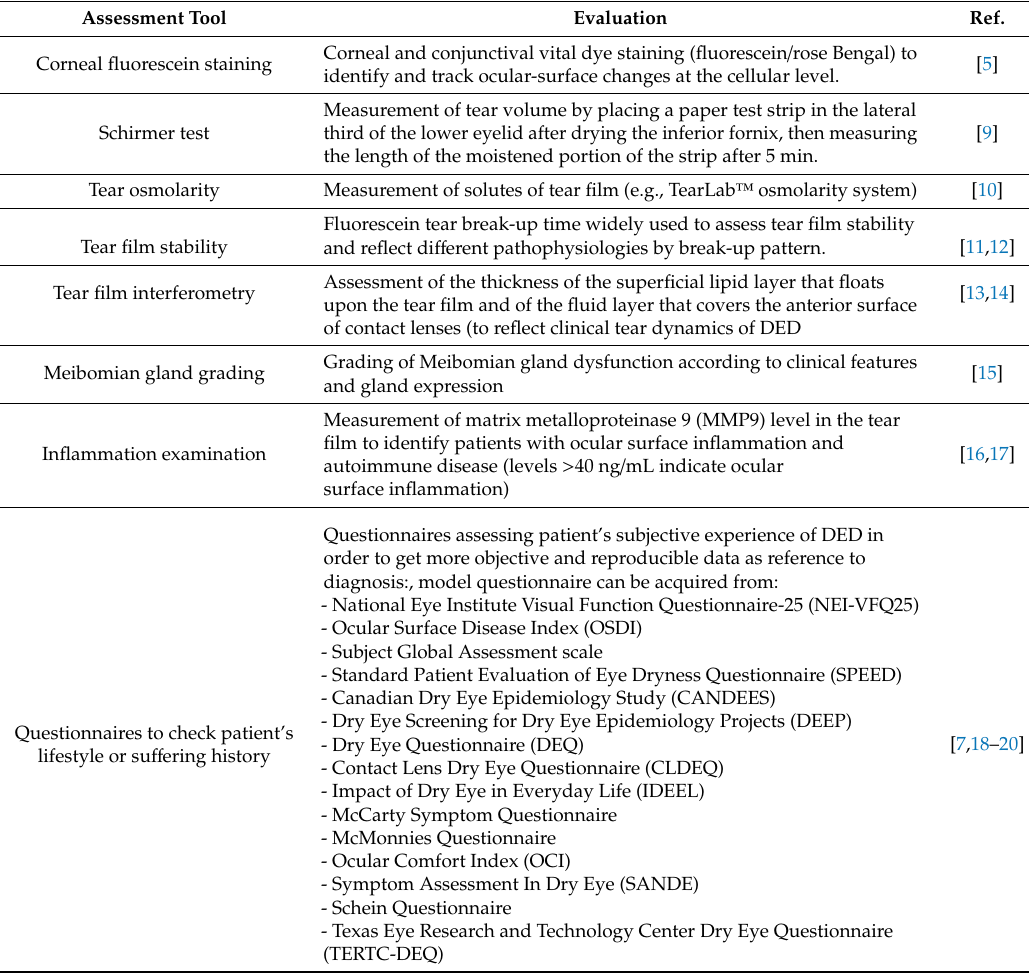
Table 1. Assessments for the diagnosis and evaluation of dry eye disease